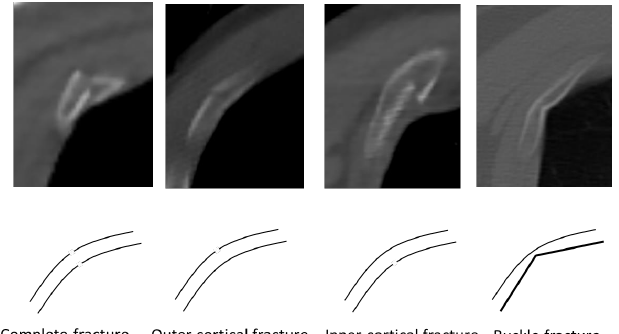
Figure 1. Type of rib fracture detected on post mortem computed tomography. A complete fracture was documented when both cortical lines were disrupted. A single dehiscence of either the outer or inner cortical line and the formation of a sharp angle at the inner cortical line called “buckle fracture” were individually documented and summarised as incomplete fractures.